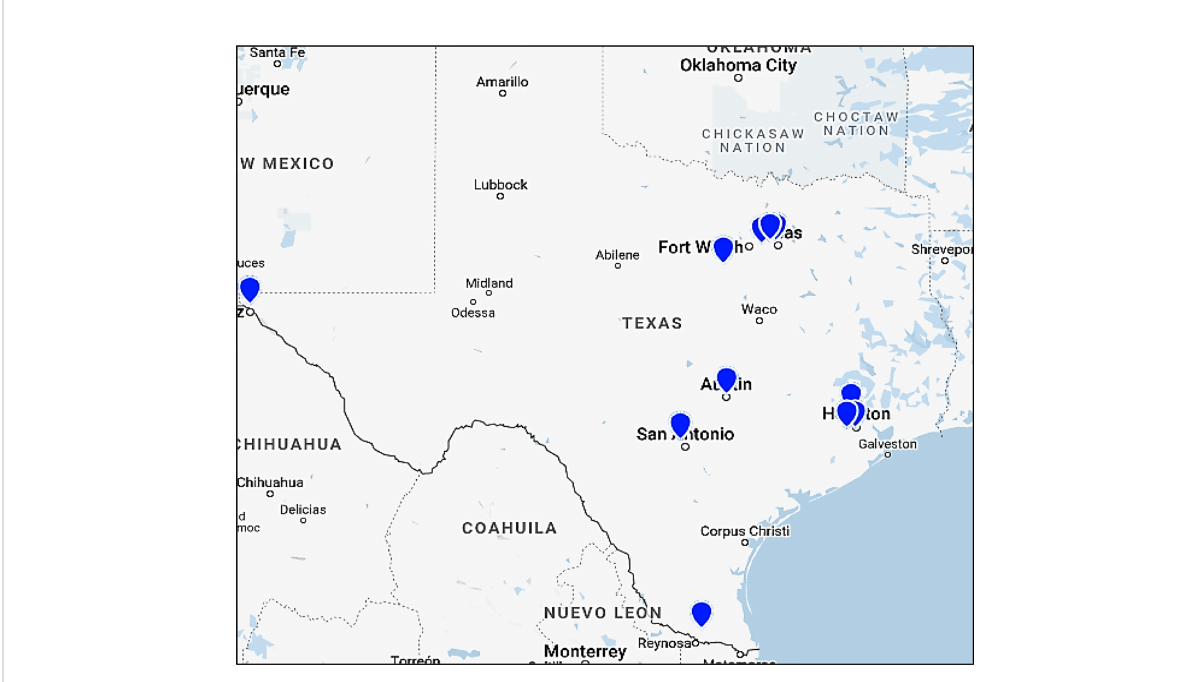
FIGURE 2 Map of the TeCH Clinical Network Committee Texas